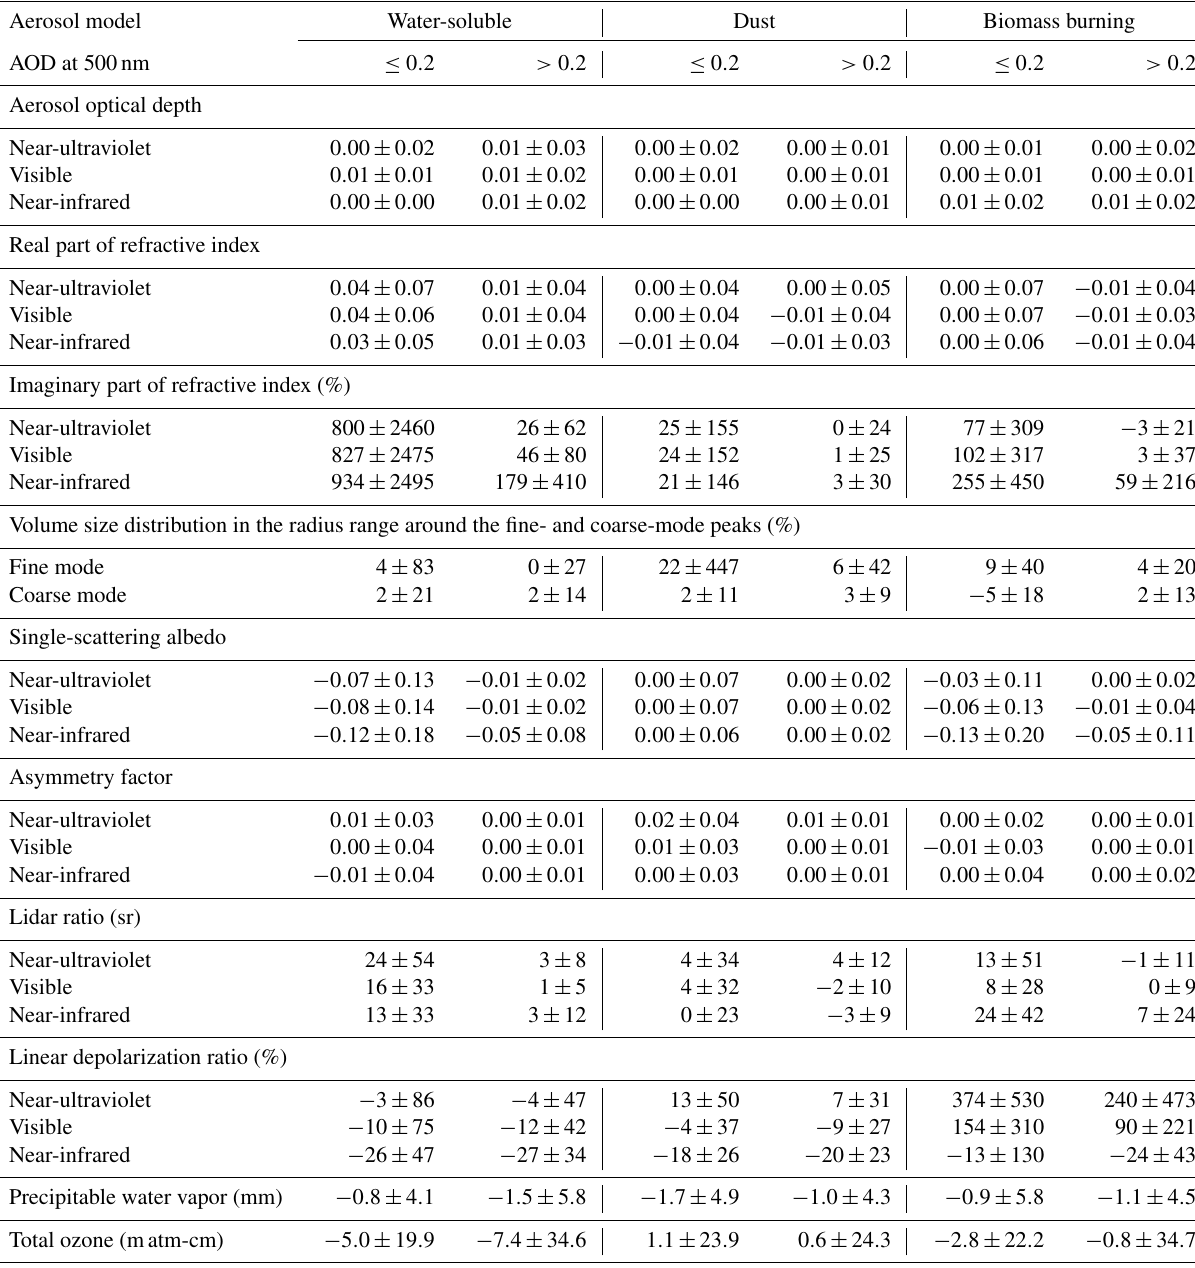
Table 3. Means and standard deviations of the retrieval errors. Aerosol model